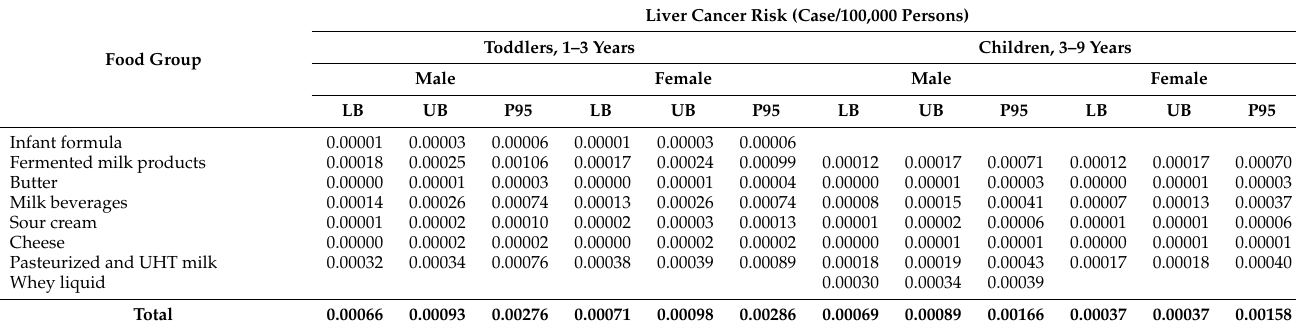
Table 6. Cancer risk estimates calculated from chronic dietary exposure to AFM1. Scenario 1